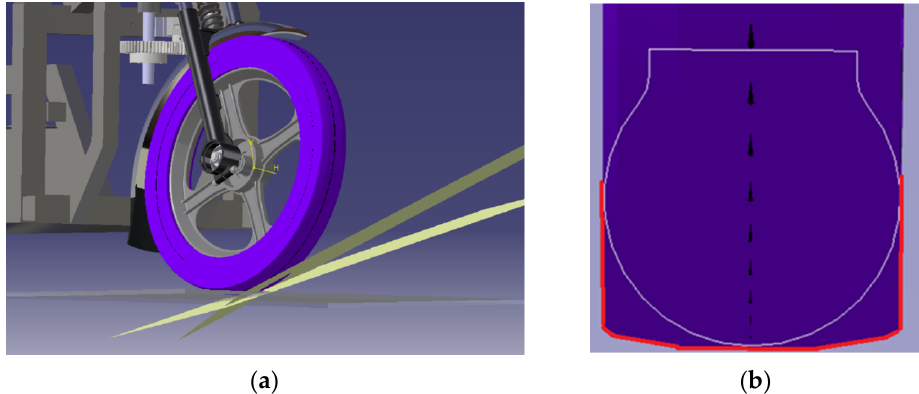
Figure 5. Forming of tire profile: ( a ) Formation of the geometry of the casing of the new tire; ( b ) Difference in the shape of the tire casing after the designed modification.